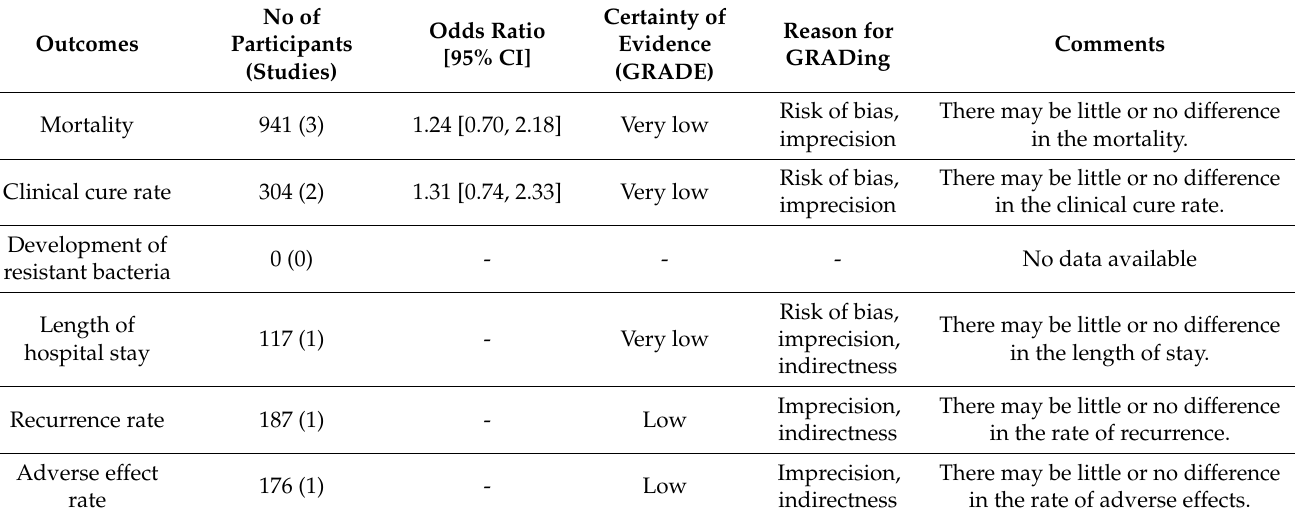
Table 4. Summary of